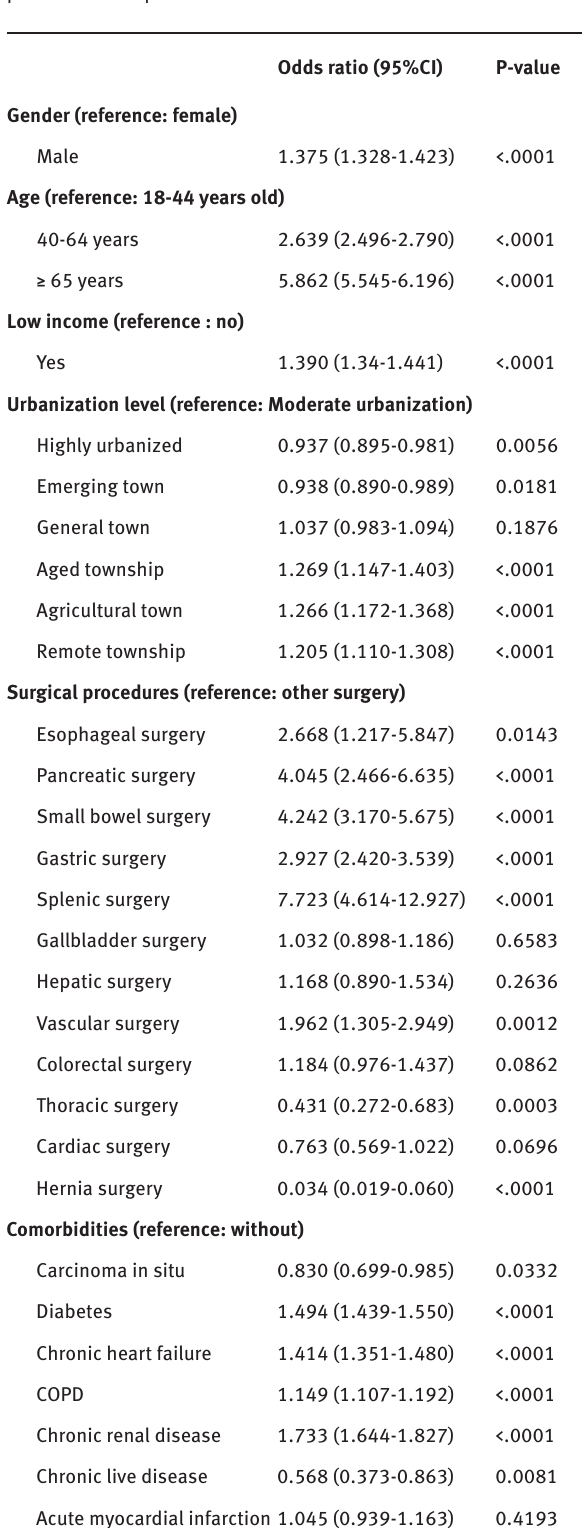
Table 2: Odds ratio and 95% confidence interval of surgery among patients with